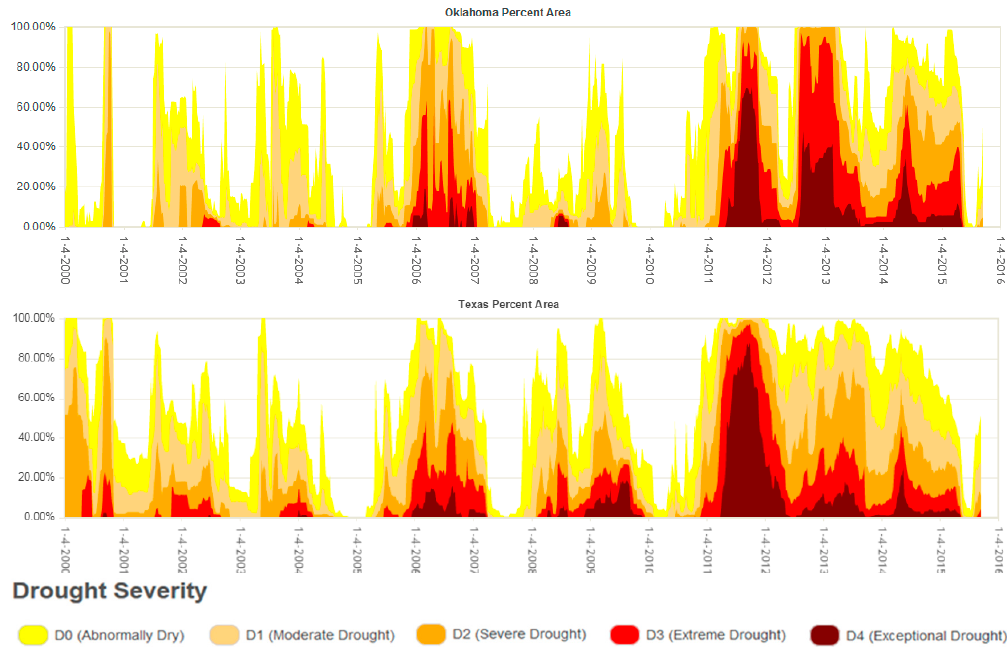
Figure 2. Drought index in Oklahoma and Texas in 2000–2016. Source: Drought Monitor [6], NDMC [7]. Legend: This figure shows categorical US Drought Monitor statistics that describe the percent of the area in a certain drought category, based on precipitation. It excludes areas that are better or worse. The statistics will add up to 100 percent for a given week.